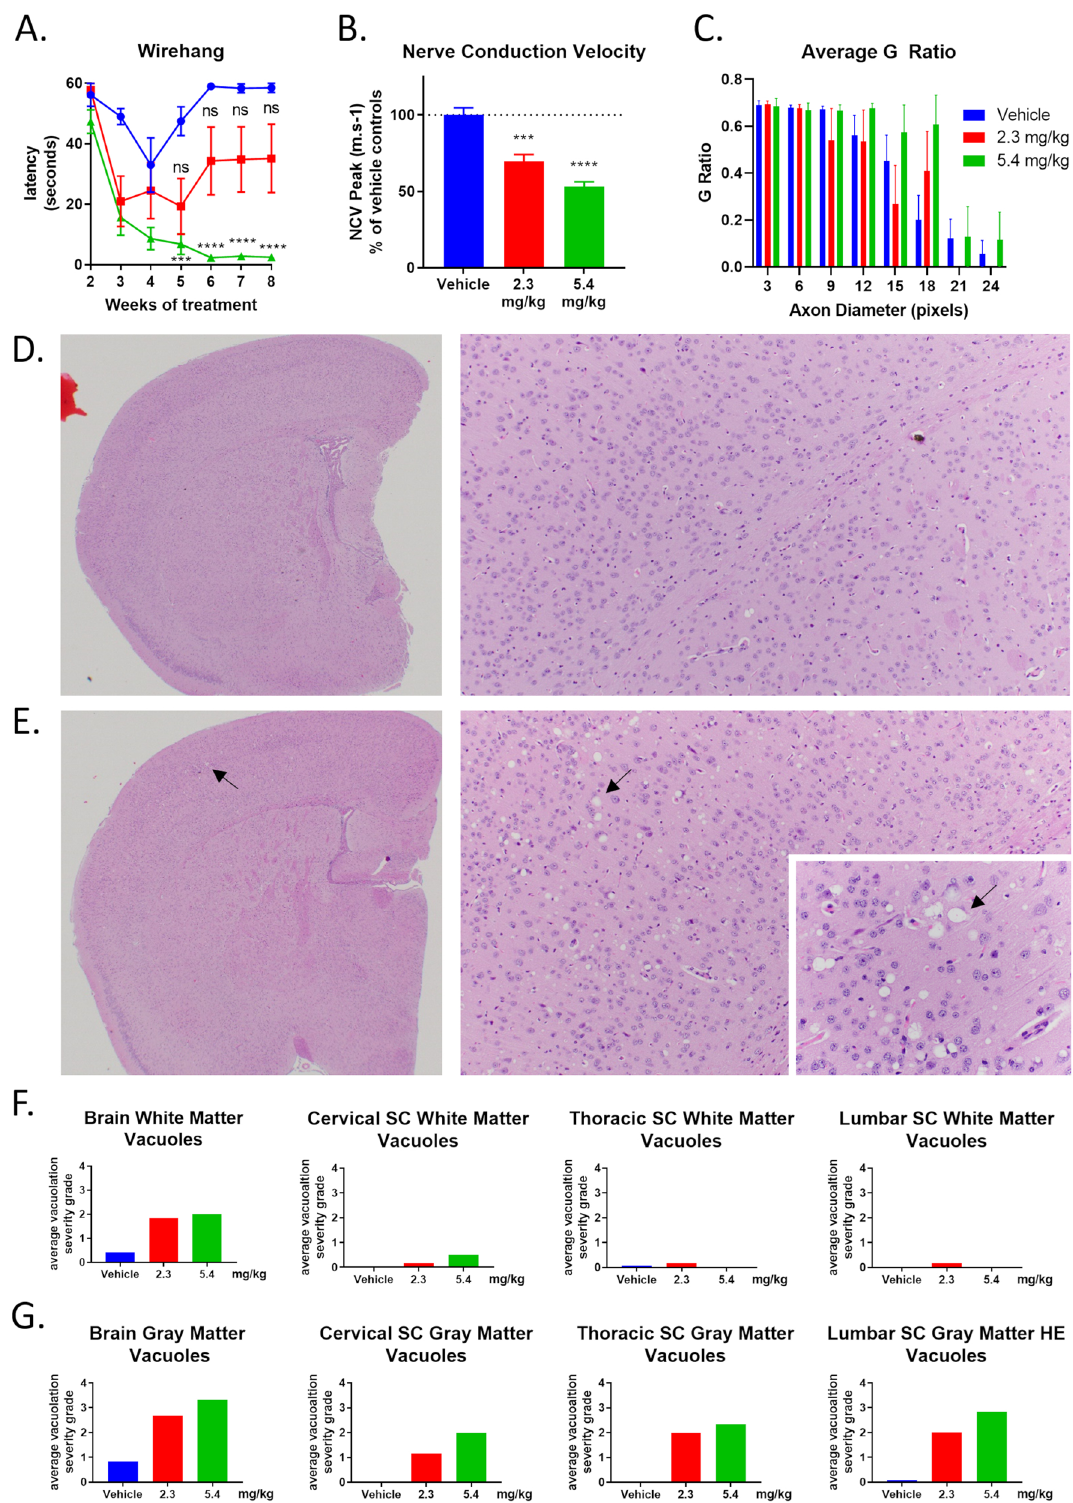
Figure 8. Chronic CGT inhibition affects PNS and CNS function and integrity. Wild-type mice were treated with S202 by IP injection three times per week for 8 weeks starting on PND15. The ability of mice to hang from a wire mesh was evaluated weekly starting on week 2 of treatment ( A ). Sciatic NCVs were recorded from mice that had been treated with S202 ( B ). G-ratio analysis of sciatic nerve ( C ). H&E stained brain sections from S202 revealed vacuolation in S202 treated animals at either dose ( E arrow) that was not seen in vehicle treated animals ( D ). Severity of vacuolation was scored by a trained pathologist on a scale of 1–4 in white matter ( F ) or gray matter ( G ) in brain and spinal cord. (n =